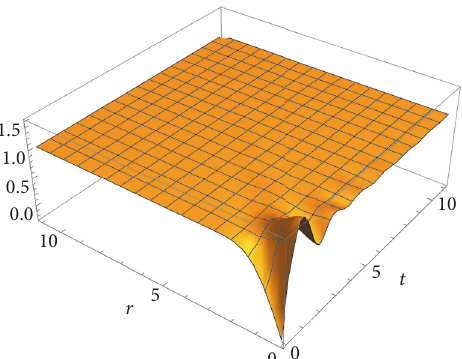
Figure 7: Numerical result of 𝐺 푅 (𝑟, 𝑡) in